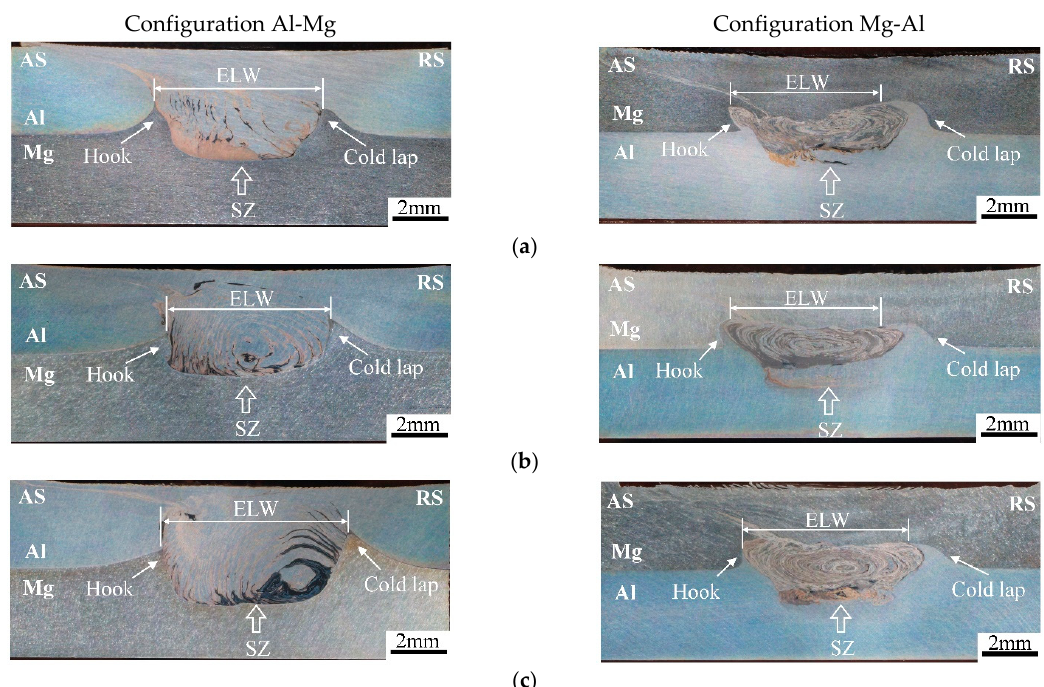
Figure 3. Macro morphologies of the weld cross sections in different lap configurations formed at different rotation speeds. ( a ) 700 rpm; ( b ) 1100 rpm; ( c ) 1500 rpm.